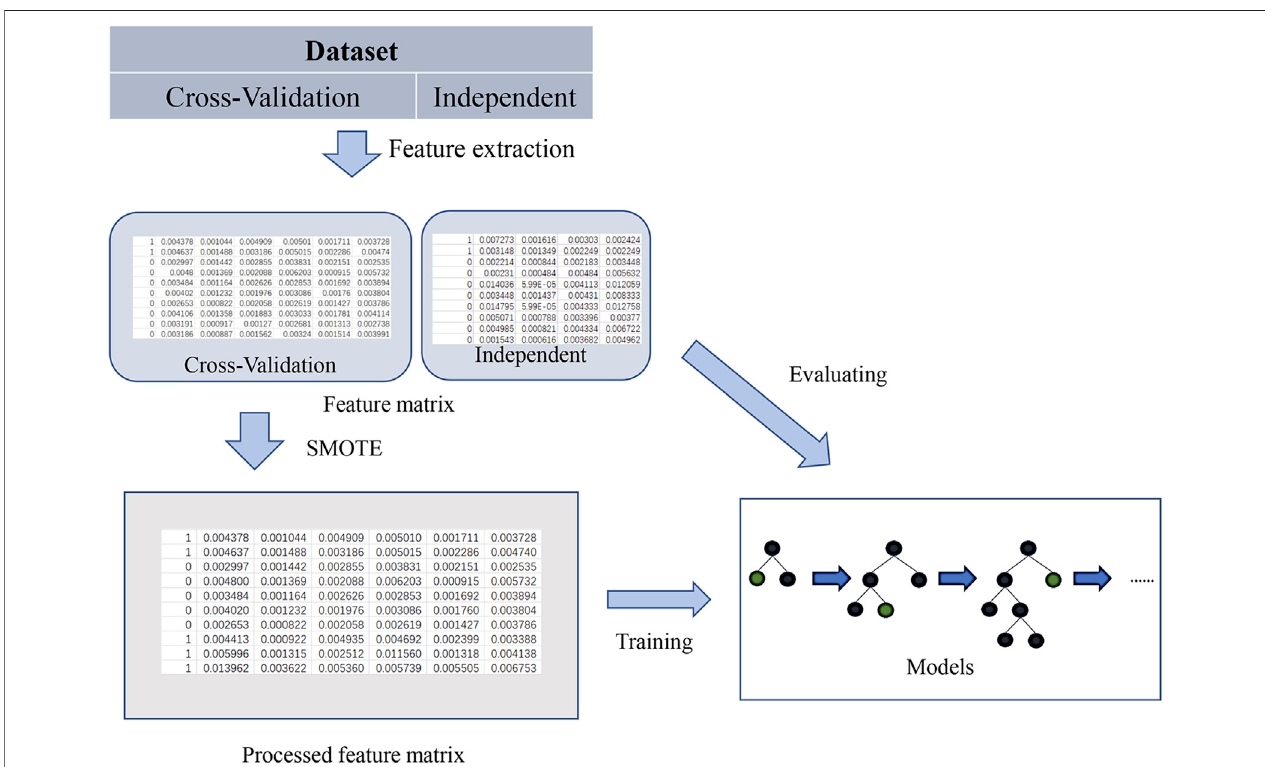
FIGURE 1 | The research fl ow diagram of SNARE protein identi fi cation using a decision tree model.